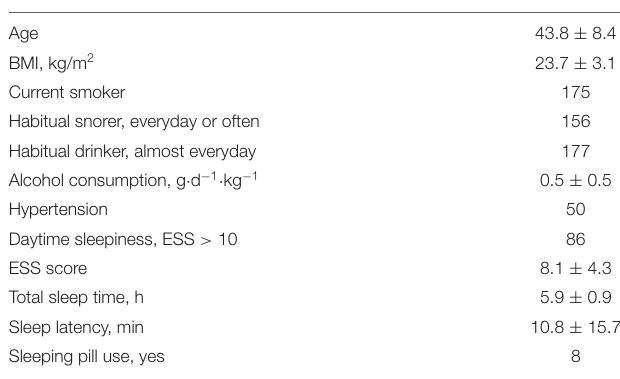
TABLE 2 | Characteristics of